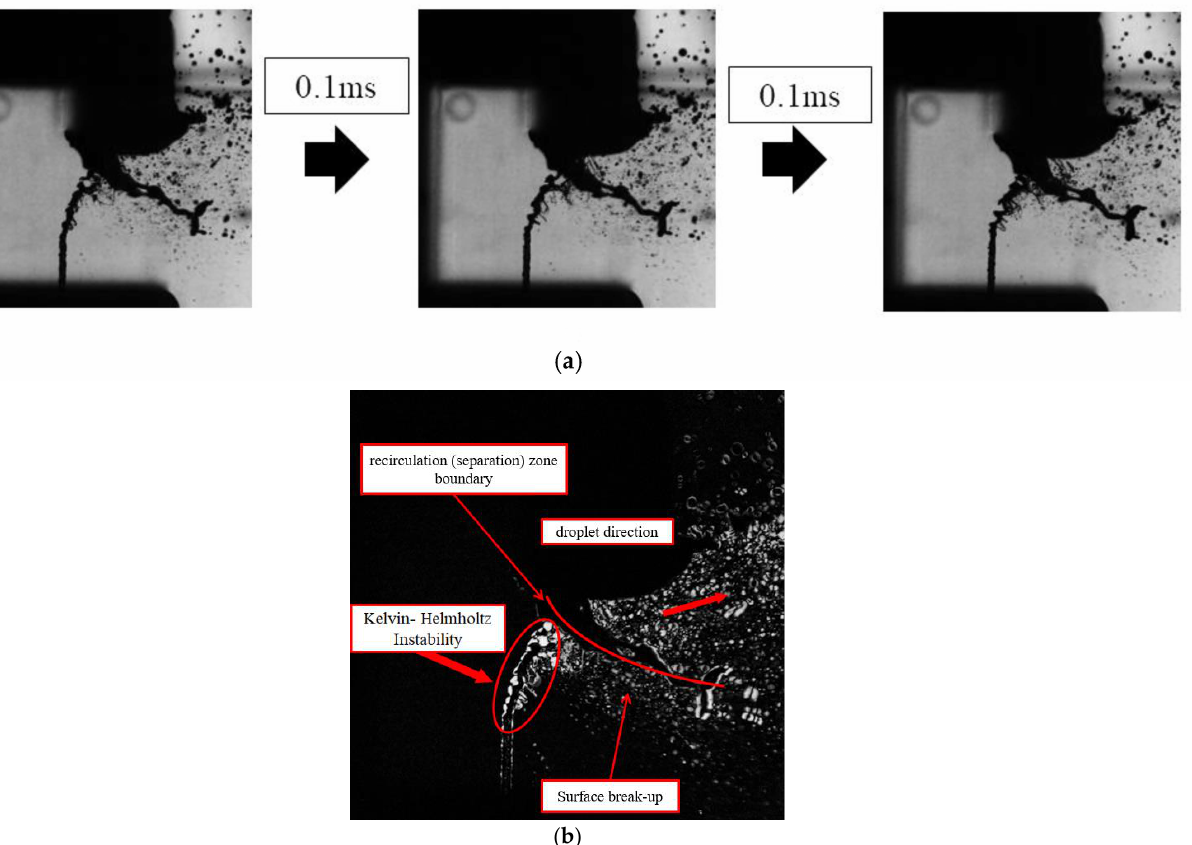
Figure 11. ( a ) Instantaneous jet images for H / d 0 = 30, We a = 6.32, and We l = 717 at 0.1-ms intervals. ( b ) Differences between the 0.1-ms interval instantaneous images of ( a ).